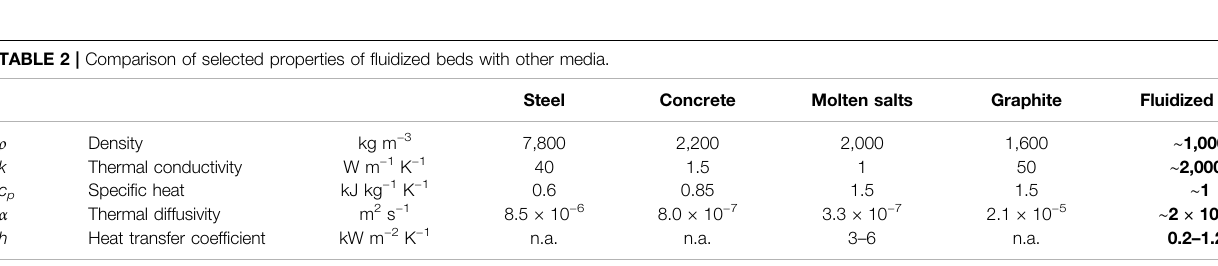
FIGURE8| Theschematicofthedirectlyirradiated fl uidizedbedautothermalreactor(reprintedfromTregambietal.(2020a),Copyright(2020)withpermissionfromElsevier).